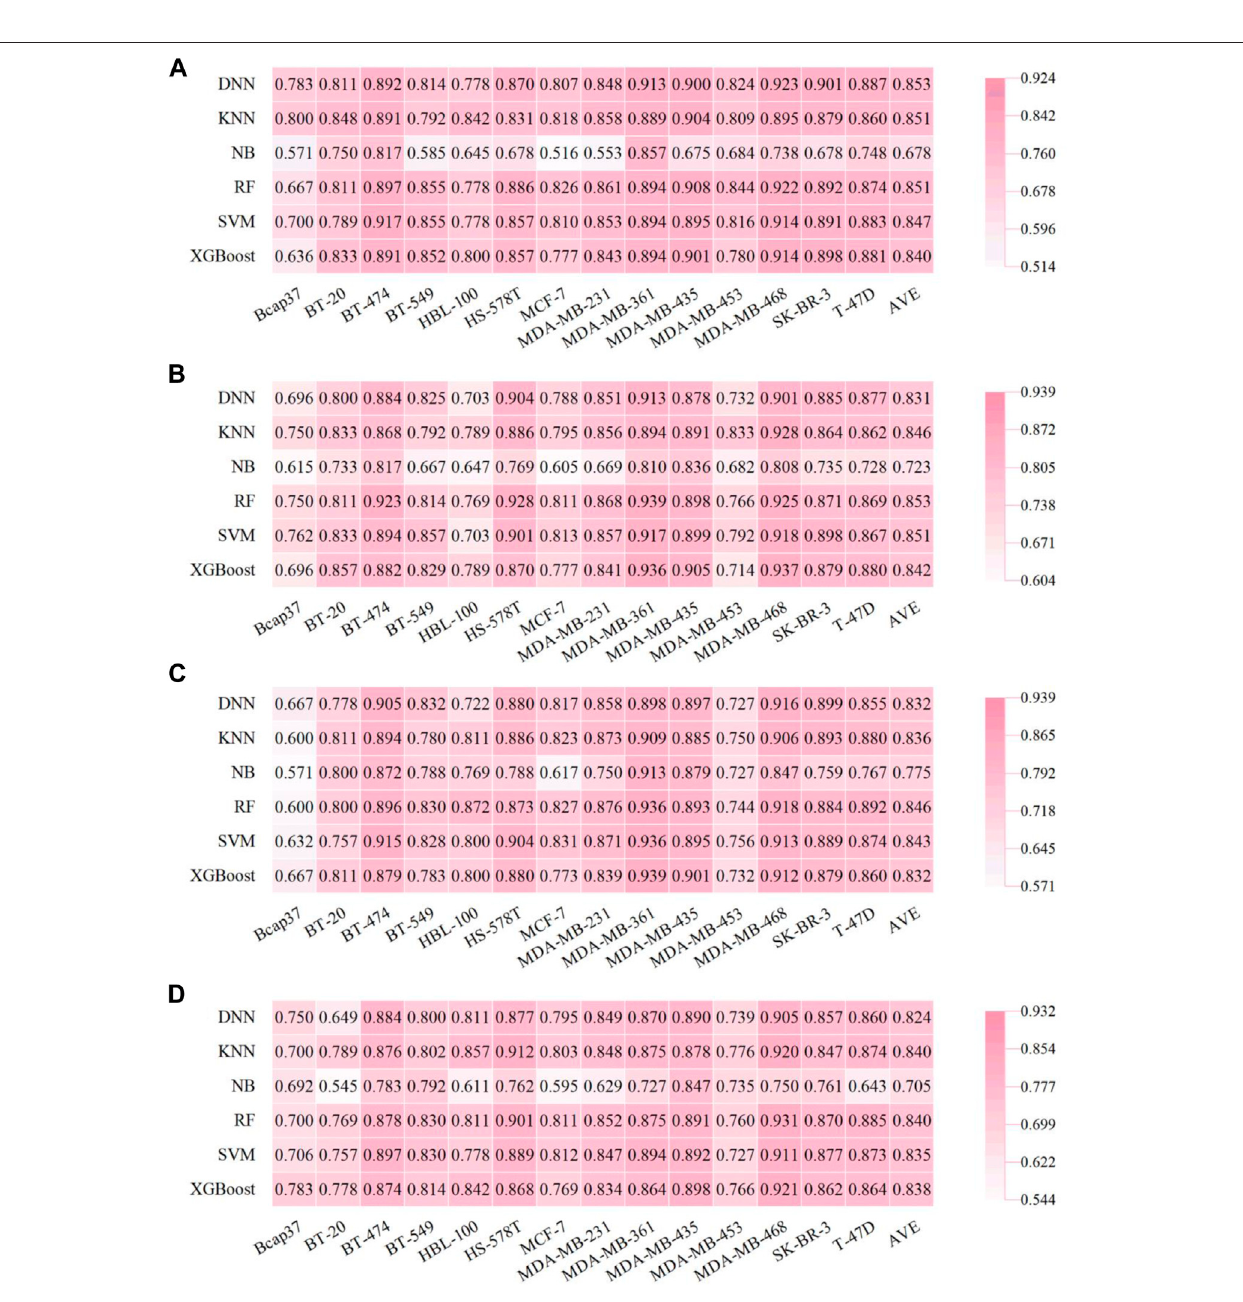
FIGURE 3 | Performance of fi ngerprint-based BC prediction models. (A) F1 scores of the AtomPairs-based models. (B) F1 scores of the MACCS-based models. (C) F1 scores of the Morgan-based models. (D) F1 scores of the PharmacoPFP-based models.